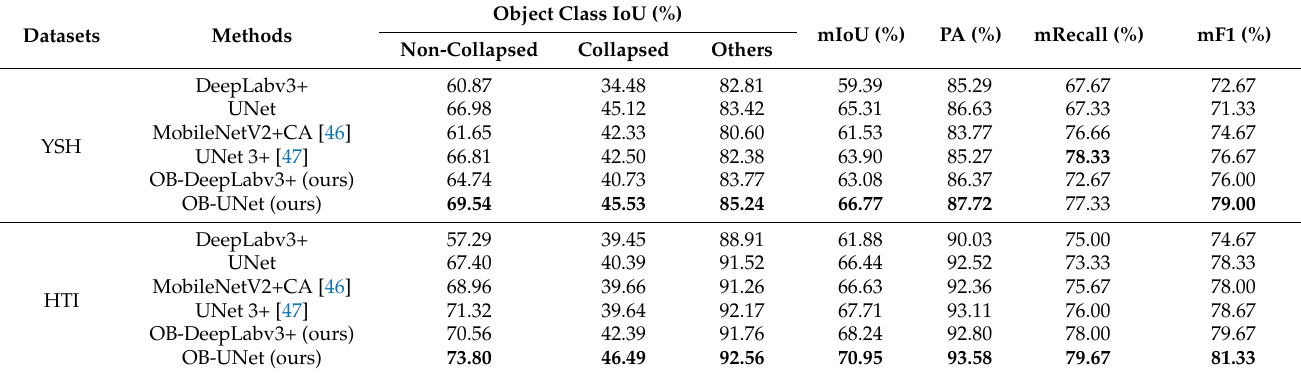
Table 1. Results of quantitative evaluation. The entries in bold denote the best on the corresponding dataset. Datasets